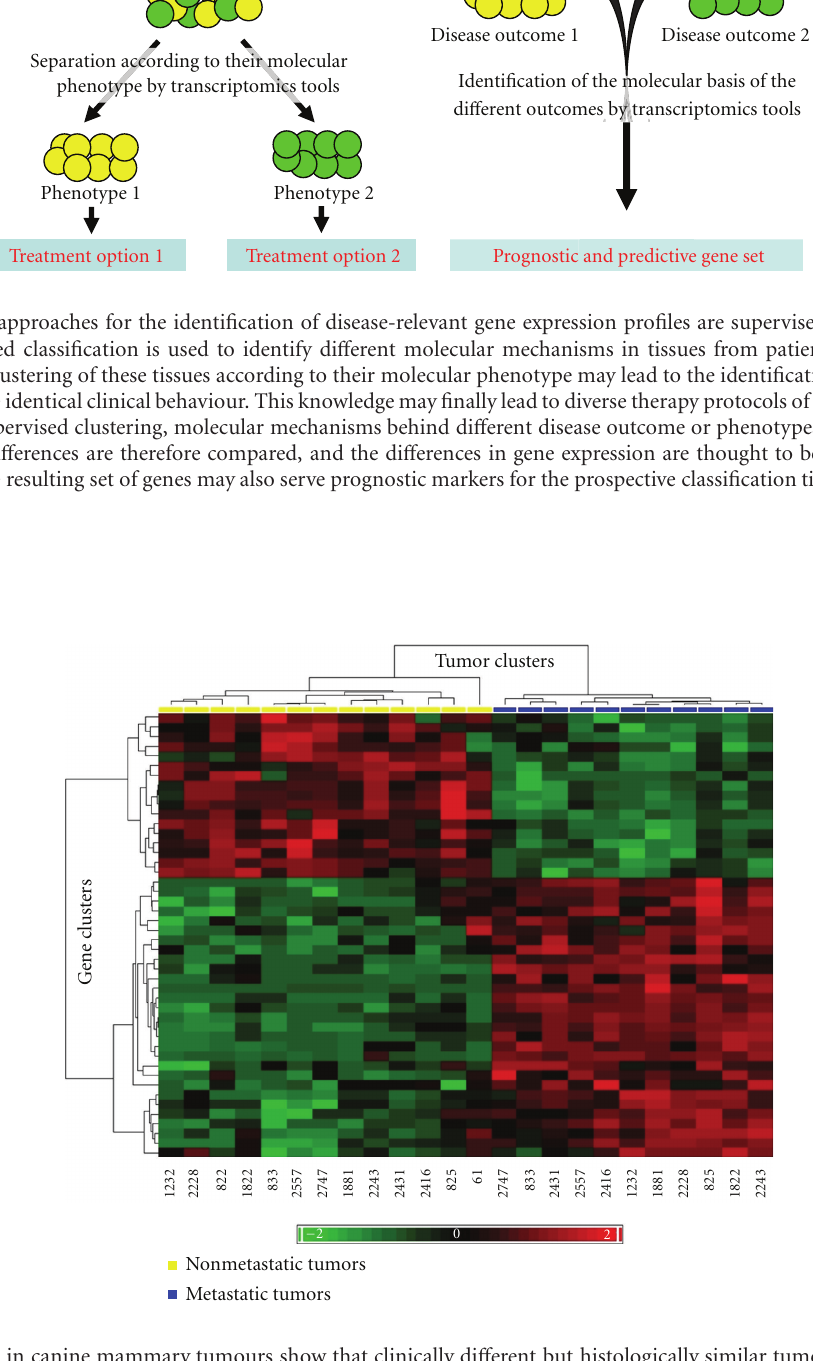
Figure 6: First studies in canine mammary tumours show that clinically di ff erent but histologically similar tumours can be clustered in a supervised approach into clinically relevant groups by a prognostically relevant gene sets (modified from